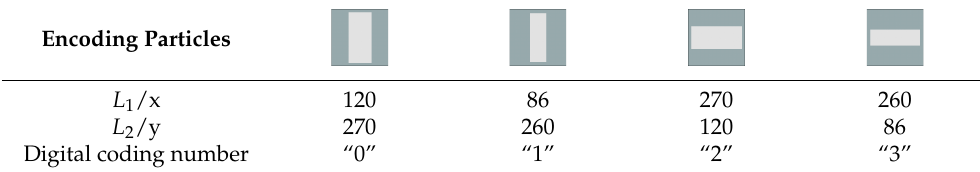
Figure 4. ( a , b ) Colors indicating the phase change of the two encoding methods.